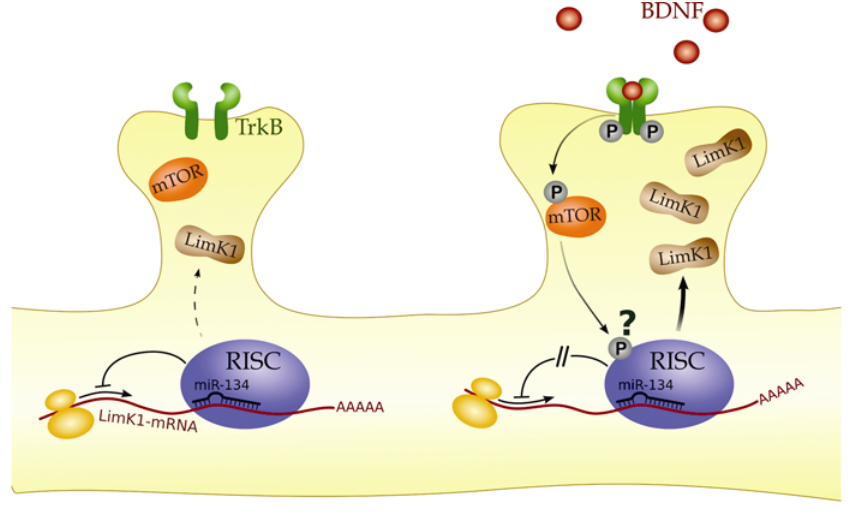
FIGURE 2. Working model for the role of microRNAs in dendritic protein synthesis and spine morphology. Left: Dendritic microRNA (i.e., miR-134) recruits the RISC to the dendritic target mRNA (i.e., Limk1), thereby inhibiting mRNA translation and restricting dendritic spine growth. Right: Synaptic stimulation triggers the release of BDNF, whose binding to the Tyrosine-kinase B (TrkB) receptor activates the downstream mammalian target of rapamycin (mTOR) kinase. This leads to an activation of Limk1 mRNA translation, presumably via post-translational modification (i.e., phosphorylation) and inactivation of inhibitory RISC components. Enhanced synthesis of microRNA targets results in dendritic spine